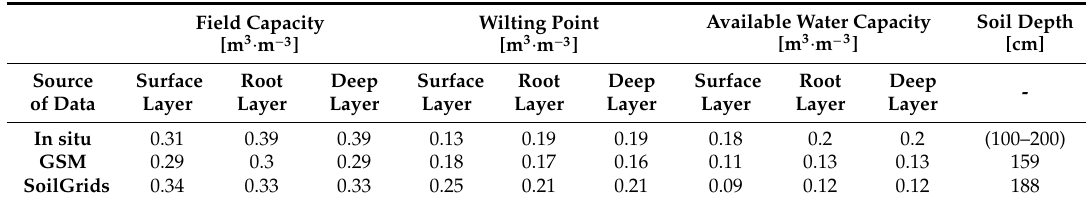
Table 3. Soil characteristics derived from in situ measurements and GlobalSoilMap and SoilGrids data at FR-Aur corresponding to 3 layers simulated by the model.